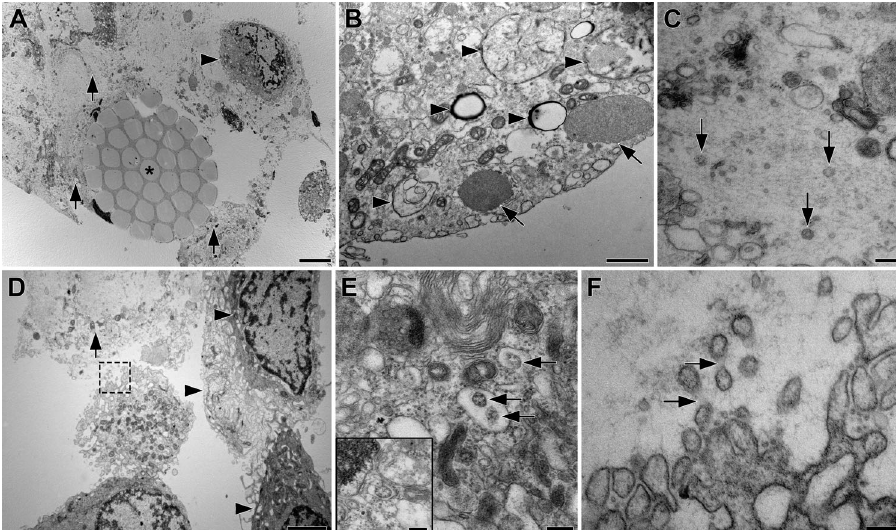
Fig. 1 TEM Images of clinical nasal swab specimens collected from a participant (subject 2), who tested positive for SARS-CoV-2 RNA by RT-qPCR. A Cross-section through a swab fi ber bundle (asterisk) with lysed (arrows) and intact cells (arrowheads); scale bar, 5 µ m. B Cytoplasm of an intact epithelial cell with possible viral double membrane assembly structures (arrowheads) and cytoplasmic aggregates of unknown origin (arrows); scale bar, 1 µ m. C Extracellular space with cytoplasmic material from lysed cells and three possible SARS-CoV-2 virions (arrows); scale bar, 200 nm. D Layer of intact epithelial cells with complex, interdigitating membrane protrusions (arrowheads) and lysed cell (arrow); scale bar, 2 µ m. The cell in the center extends membrane protrusions into the lysed material outlined with a dashed box, shown at higher magni fi cation in F . E Cytoplasm of an epithelial cell showing “ outside-in ” ribosomal structures (arrows) 22 that are easily mistaken for virions, but are generated by budding of rER membranes into the lumen (insert); scale bar, 200 nm. F Plasma membrane of the boxed cell in D with convoluted membrane protrusions that are easily mistaken for virions, but can be identi fi ed as protrusions by faint connecting densities (arrows); scale bar, 200